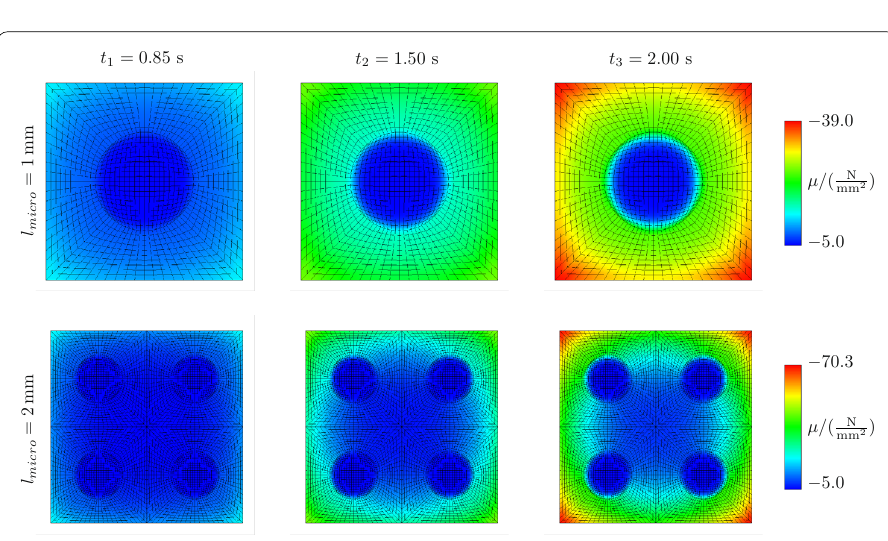
Fig. 8 Chemical potential field μ inconsiderationoftwodifferentperiodicRVEsatthreedifferentinstancesof time. Although the considered RVEs are composed of periodic unit cells, we observe remarkable differences in their response. The chemical parameters for the matrix and the inclusions are A mat = A incl = 10N/mm 2 . The mobility parameter of the matrix is given by M mat = 0 . 01mm 4 /(Ns) and the mobility parameter of the inclusions is M incl = 10 − 4 mm 4 /(Ns)